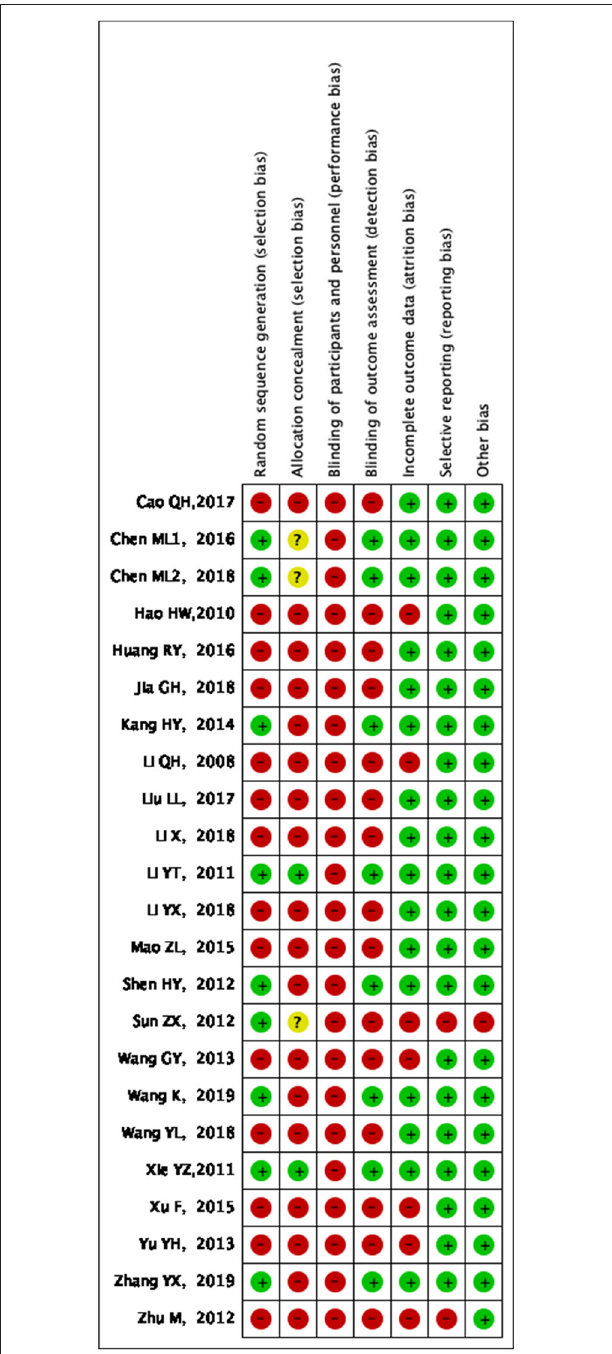
FIGURE 3 | Bias risk summary: judgment of risk of bias and items with bias included in the studies; “ + ” = low risk, “–” = high risk, “?” = unclear.